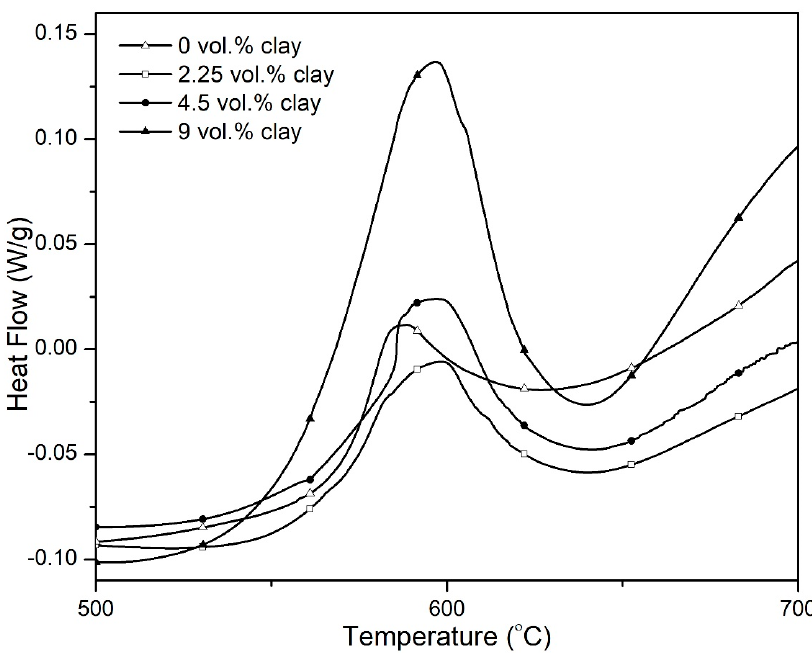
Figure 10. DSC thermograms for the hybrid composites obtained in nitrogen atmosphere at a heating rate of 10 °C/min.